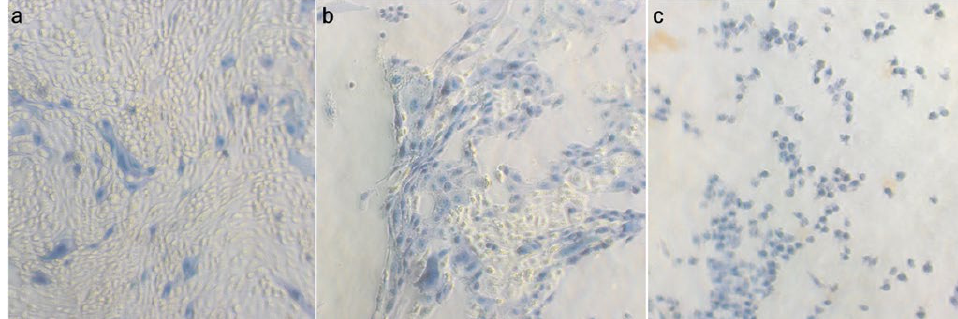
Figure 3. Staining of endometrial epithelial cells with trypan blue after co-culturing with B. pumilus strain BP13 at MOI 5: ( a ) at 24 h; ( b ) at 48 h; ( c ) at 72 h post-infection. Cellular detachment is evident after 48 h.